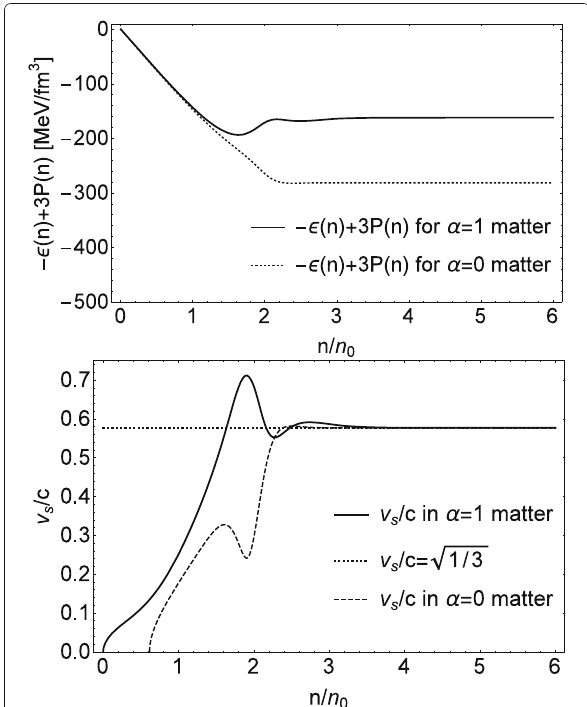
Fig. 5 (cid:6) θ μ μ (cid:7) (upper panel) and v s (lower panel) vs. density for α = 0 (nuclearmatter)and α = 1(neutronmatter)in V lowk RGfor n 1 / 2 = 2 n 0 Fig. 6 Sound velocity as a function of density in neutron matter